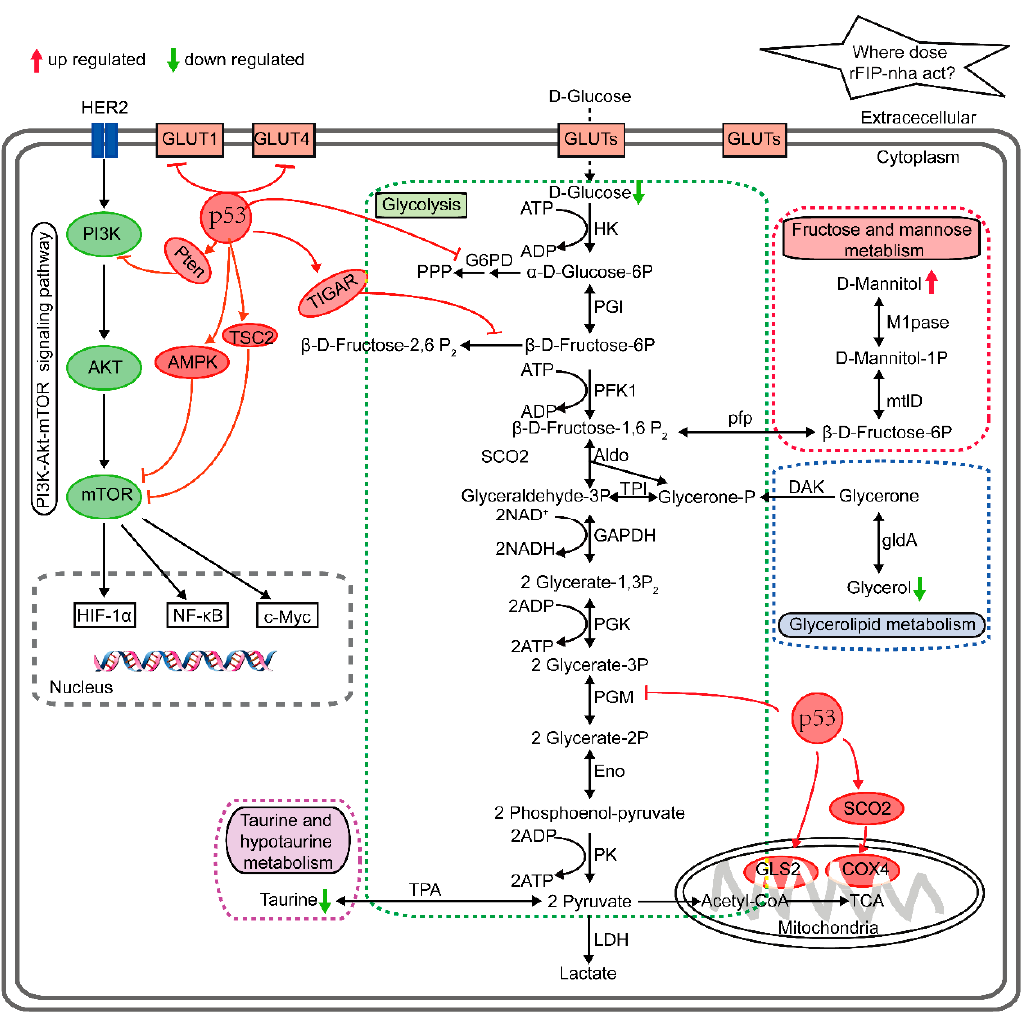
Figure 5. Summary of altered metabolic pathways and regulatory mechanism of rFIP-nha against A549 cells. HK, hexokinase; PGI, phosphoglucose isomerase; PFK1, phosphofructokinase 1; Aldo, aldolase; TPI, triose phosphate isomerase; GAPDH, glyceraldehyde 3-phosphate dehydrogenase; PGK, phosphoglycerate kinase; PGM, phosphoglycerate mutase; Eno, enolase; PK, pyruvate kinase; LDH, lactate dehydrogenase; TCA, tricarboxylic acid cycle; G6PD, glucose-6-phosphate dehydrogenase; TPA, taurine-pyruvate aminotransferase; pfp, pyrophosphate-fructose-6-phosphate 1-phosphotransferase; mtlD, mannitol-1-phosphate 5-dehydrogenase; M1Pase, mannitol-1-phosphatase; gldA, glycerol dehydrogenase; DAK, dihydroxyacetone kinase; GLUTs, glucose transporters; HER2, receptor tyrosine-protein kinase erbB-2; PI3K, phosphatidylinositol 3-kinase; Akt, serine-threonine kinase; mTOR, mammalian target of rapamycin; HIF-1 α , hypoxia-inducible factor 1 α ; NF- κ B, nuclear factor kappa-light-chain-enhancer of activated B cells; c-Myc, a transcription factor; p53, a tumor suppressor; Pten, a human tumor suppressor gene on chromosome 10; AMPK, AMP-activated protein kinase; TSC2, tuberous sclerosis complex 2; TIGAR, TP53-induced glycolysis and apoptosis regulator; GLS2, glutaminase 2; SCO2, cytochrome c oxidase 2; COX4, cytochrome c oxidase subunit 4. HER2-mediated PI3K-Akt-mTOR signaling plays a pivotal role in promoting glycolysis in tumor cells via the activation of HIF-1 α , NF- κ B, and c-Myc. p53 plays a key role in the process of suppressing glycolysis and promoting oxidative phosphorylation (OXPHOS) by interacting with various enzymes and other molecules, including SCO2, TIGAR, GLUT1, GLUT4, GLS2, and PGM. Different metabolic pathways represented within the dashed box. The arrow represents stimulatory modification, the T-shaped arrow represents inhibitory modification.